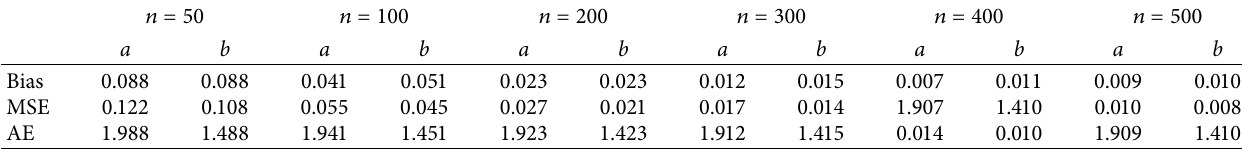
Table 2: Biases, MSEs, and AE for